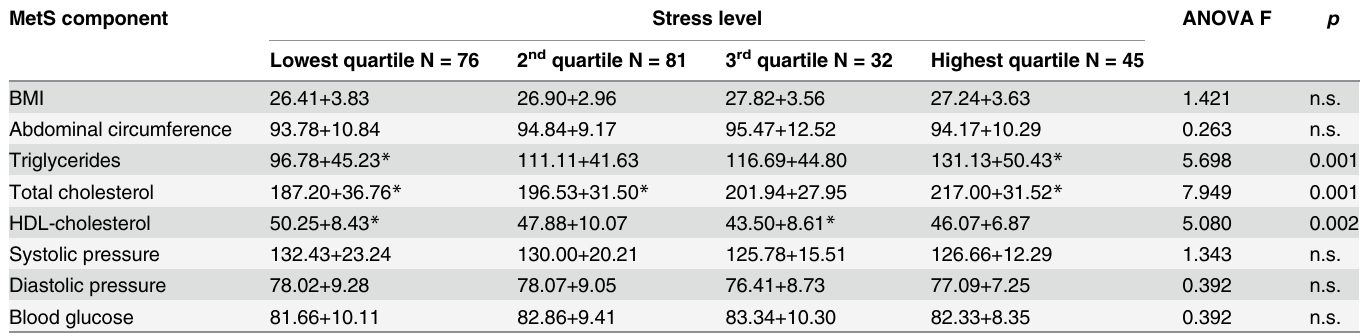
Table 2. Difference between groups exposed to different levels of work stress.